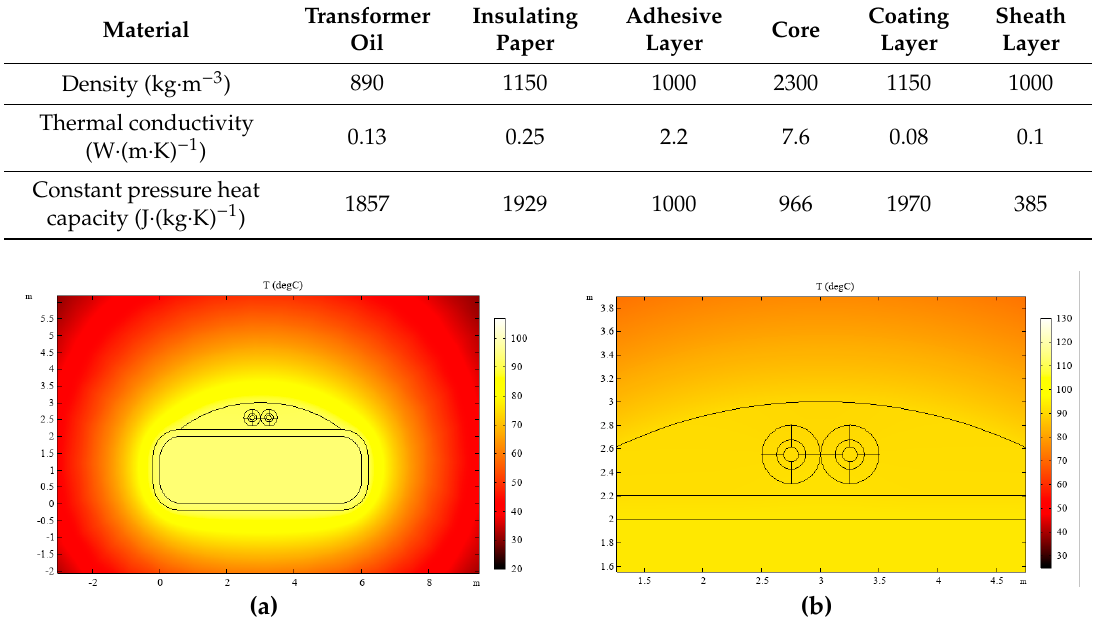
Figure 7. ( a ) Temperature distribution of optical fibre composite conductor and ( b ) temperature distribution in the optical fibre.